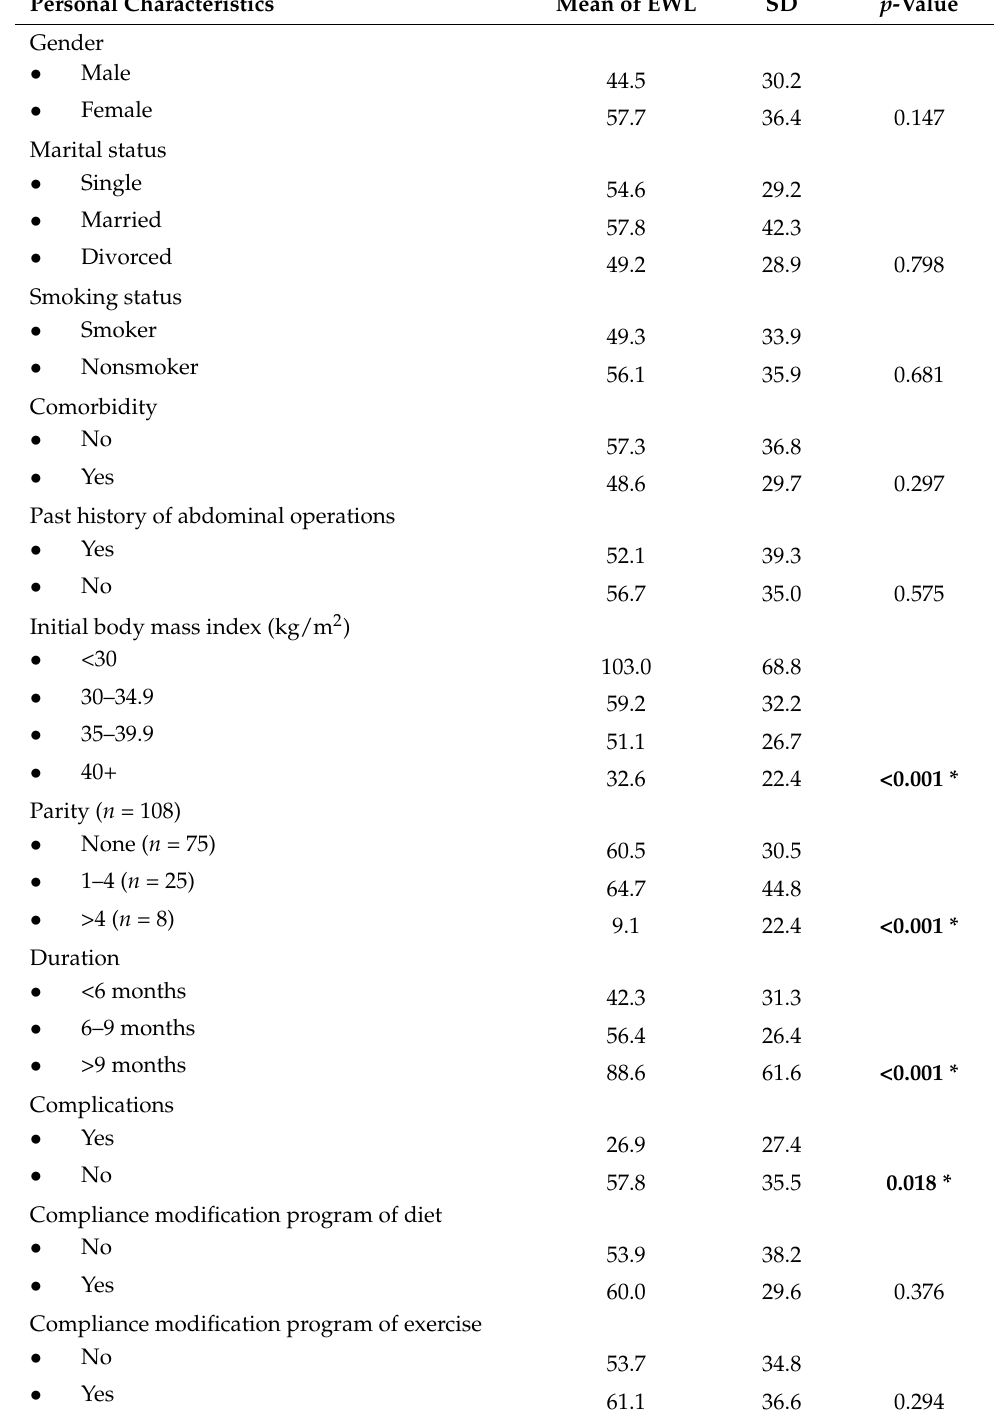
Table 3. Participants’ percent excess weight loss (mean ± SD) according to their personal characteris- tics and clinical